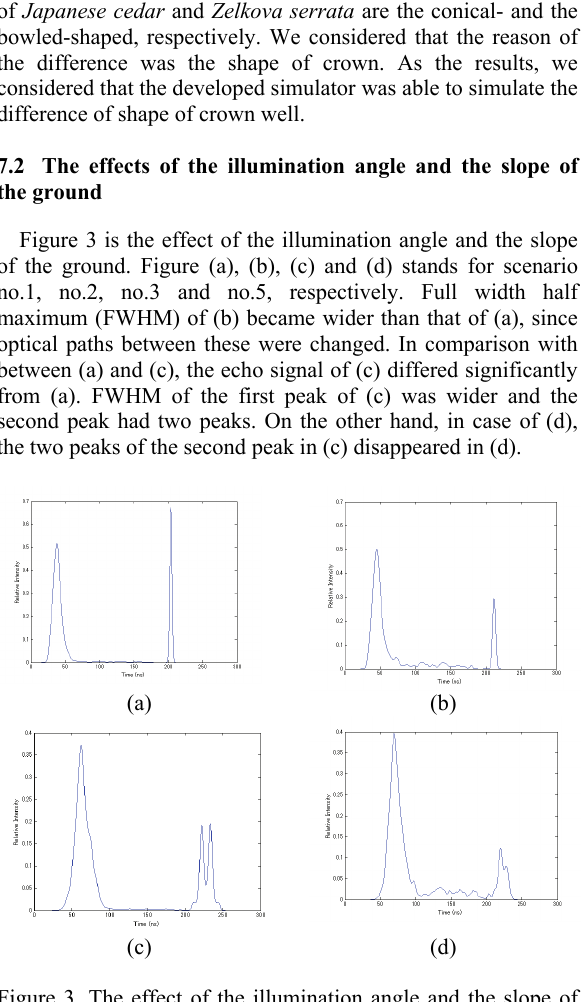
Figure 3. The effect of the illumination angle and the slope of the ground. (a), (b), (c) and (d) stands for scenario no.1, no.2, no.3 and no.5, respectively.